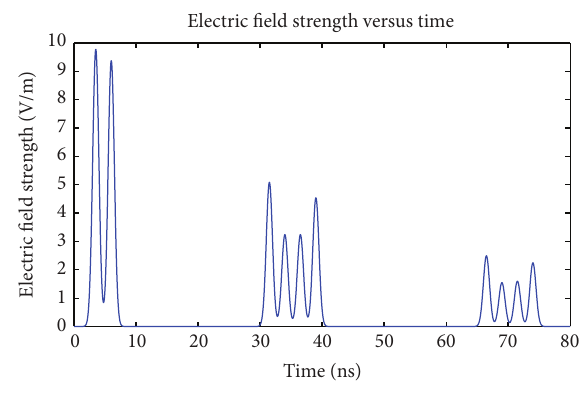
Figure 4: Waveform of sensor